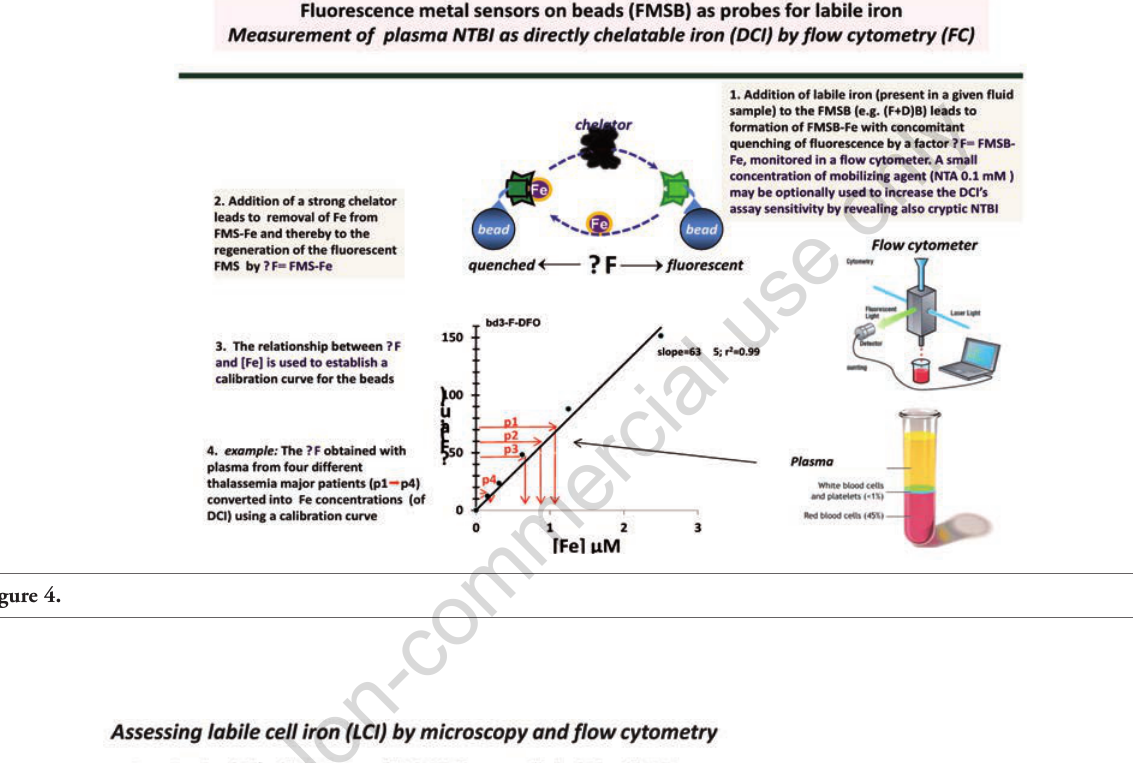
Fig.5 (bottom right)Measurement of LCI by flow cytometry. The upper figure depicts the labeling of K562 ery- throleukemia cells with calcein-green (CALG) via its acetomethoxy AM precur- sor before and after addition of the chela- tor (100 µM DFP). The lower left panel depicts the fluorescence distributions of the cells obtained in a flow cytometry before and after addition of DFP. The change in fluorescence elicited by the cell permeant chelator ΔF provides a measure of LCI. The lower right graph provides the calibration curve for converting ΔF to LCI by using CALG-beads and titrat- ing them with known amounts of Fe. A plot of the weighted reciprocal change in fluorescence[Fe]/[ΔF]vs [Fe] was linear for a wide range of [Fe], allowing conver- sion of shifts in fluorescence of CAL- laden cells elicited by chelators (ΔF) into concentrations (µM), as described else-